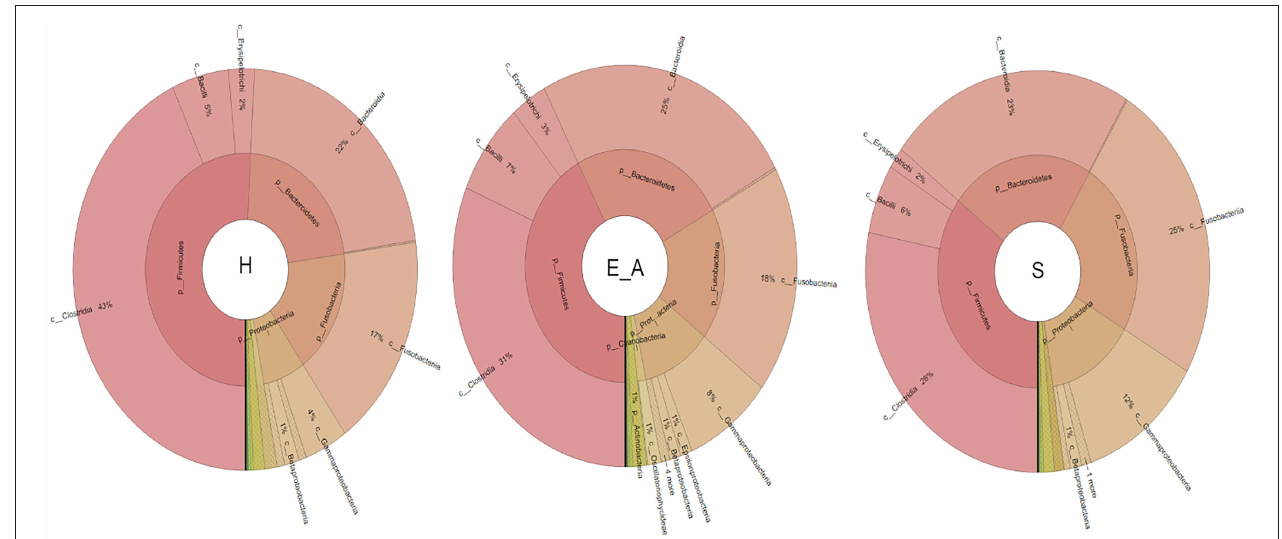
FIGURE 4 | Microbiota composition of the three groups. Phyla and healthy classes of the bacteria sequenced in healthy (H), exposed asymptomatic (E_A) and symptomatic (S) dogs are represented through a Krona chart.